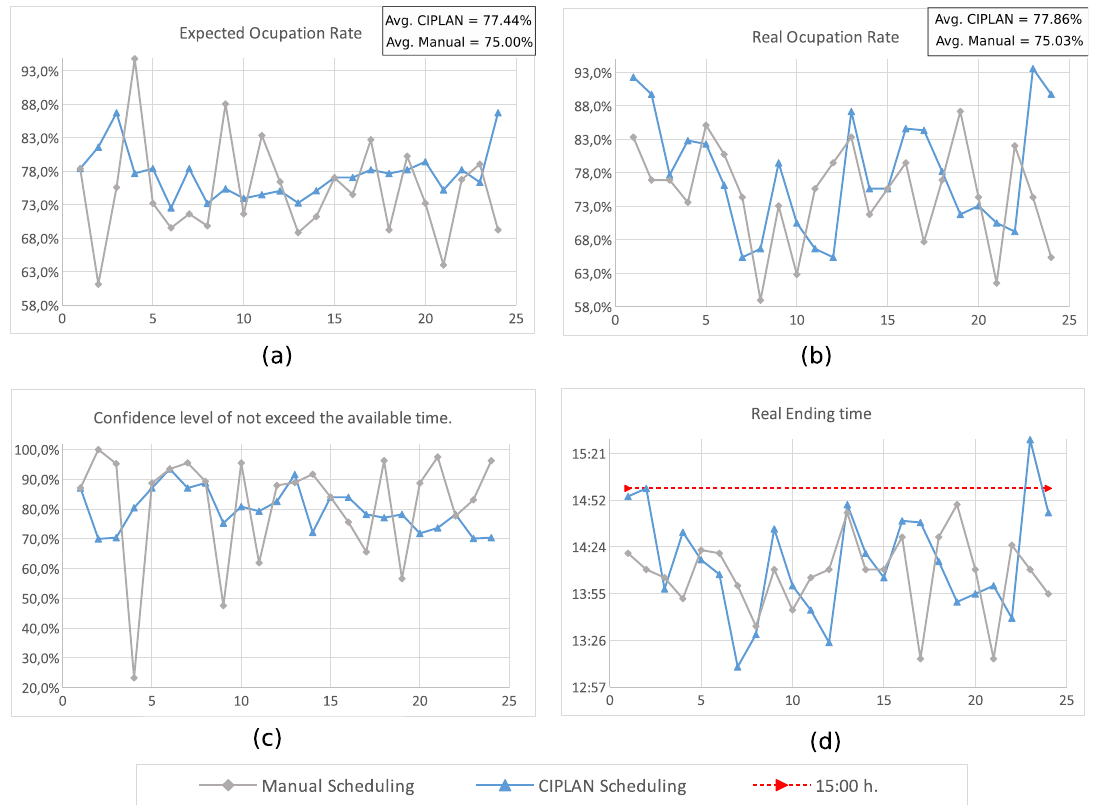
Figure 4. Comparison of manual and CIPLAN scheduling. A set of 24 time blocks has been scheduled manually and using CIPLAN. The following values are shown: ( a ) expected occupation rate; ( b ) real occupation rate; ( c ) confidence level of not exceeded the available time; ( d ) ending